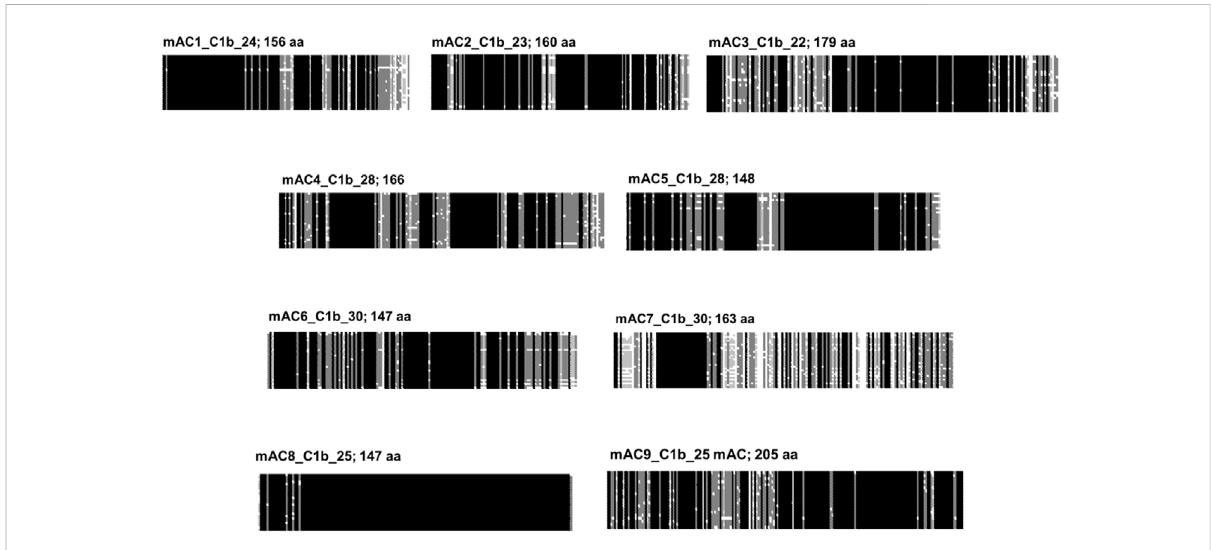
FIGURE 8 Alignment of the C1b subdomains of the mammalian mAC isoforms. The number of isozymes used for each alignment and the respective C-terminal lengths are indicated above. Shading: black, invariant; dark grey, conserved; light grey, slightly conserved; white: